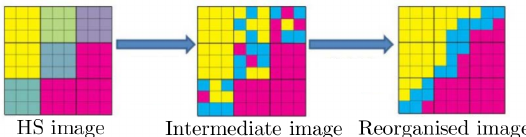
Figure 2. Description of the spatial reorganisation